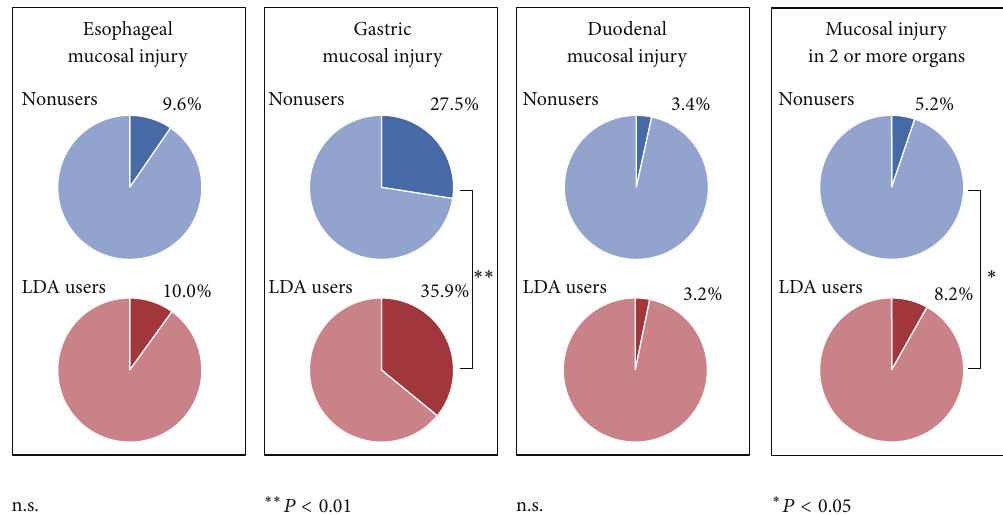
Figure 2: Prevalence of esophageal, gastric, and duodenal mucosal injury and concurrent mucosal injury in 2 or more organs in LDA users and nonusers. Prevalence in LDA users and nonusers was, respectively, 10.0% and 9.6% ( 𝑃 = 0.83 ) for esophageal mucosal injury, 35.9% and 27.5% ( 𝑃 = 0.003 ) for gastric mucosal injury, and 3.2% and 3.4% ( 𝑃 = 0.84 ) for duodenal mucosal injury. The prevalence of mucosal injury in 2 more organs was 8.2% in LDA users and 5.2% ( 𝑃 = 0.04 ) in nonusers. n.s. = not significant.